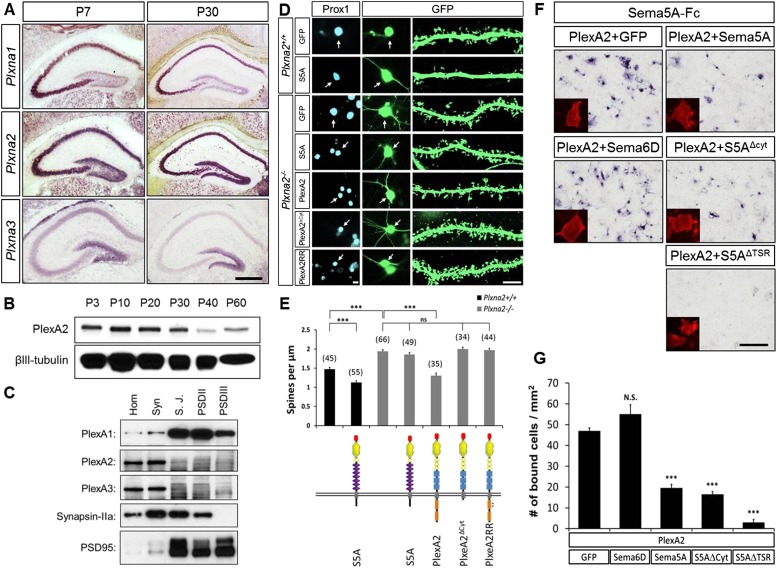
In dentate GCs, PlexA2 is necessary for Sema5A-mediated regulation of dendritic spine density.(A) Coronal sections of P7 and P30 mouse hippocampus labeled with riboprobes specific for Plxna1, Plxna2, and Plxna3 transcripts. In the DG, strong expression of Plxna2 is observed, while Plxna1 is virtually absent. Plxna3 mRNA expression is largely confined to more immature GCs located near the inner surface of the GCL. (B) Developmental time course of PlexA2 protein expression in the mouse hippocampus between P3 and P60, normalized to βIII-tubulin. (C) Distribution of PlexA1, PlexA2, and PlexA3 in synaptic density fractions prepared from P23 mouse hippocampus. The three PlexA family members are present in the synaptosomal (syn) fraction. PlexA1, but not PlexA2 or PlexA3, is enriched in the synaptic junction (S.J.) and postsynaptic density (PSD) fractions. As controls, markers enriched in postsynaptic fractions (anti-PSD95) and presynaptic fractions (anti-Synapsin-IIa) are shown. n = 4 independent experiments. (D) Representative images of DIV21 GCs from Plxna2+/+ and Plxna2−/− mice transfected with GFP alone or GFP plus myc-tagged FL-Sema5A (S5A), FL-PlexA2 (PlexA2), PlexA2Δcyt, or PlexA2RR expression constructs. Cultures were fixed and stained with anti-Prox1 (blue) and anti-GFP (green). The cell bodies of GFP-expressing GCs are labeled with an arrow and a dendritic segment of the same neuron is shown. (E) Quantification of spine density of GCs shown in panel D. WT neurons (black bars) and Plxna2−/− mutant neurons (grey bars). Numbers in brackets indicate GCs analyzed per condition. Values are represented as mean ± SEM from three animals for each condition. (F) Cis interaction between Sema5A and PlexinA2. Membrane-bound Sema5A presented in cis, and soluble Sema5A-Fc presented in trans, compete for binding to PlexinA2. Sema5A-Fc binding to COS7 cells transiently transfected to co-express PlexA2 and GFP, PlexA2 and Sema6D, PlexA2 and Sema5A, PlexA2 and Sema5A lacking the cytoplasmic domain (S5AΔcyt), or PlexA2 and Sema5A lacking the seven thrombospondin type-1 domains (S5AΔTSR). Prior to binding, Sema5A-Fc was super-clustered with anti-Fc conjugated to human placental alkaline phosphatase (Robak et al., 2009). Surface expression of recombinant PlexA2 was confirmed in a parallel experiment by immunofluorescence labeling of its N-terminal myc epitope (small inserts). (G) Quantification of Sema5A-Fc bound to COS7 cells co-expressing PlexA2 together with GFP, Sema6D, Sema5A, S5AΔcyt, or S5AΔTSR. Cis expression of Sema5A constructs that harbor the sema domain significantly attenuates the binding of bath applied Sema5A-Fc to PlexA2. Error bars represent SEM from three independent experiments. ***indicates p < 0.0001. Two-tailed unpaired Student's t test. Scale bar in A = 50 µm.